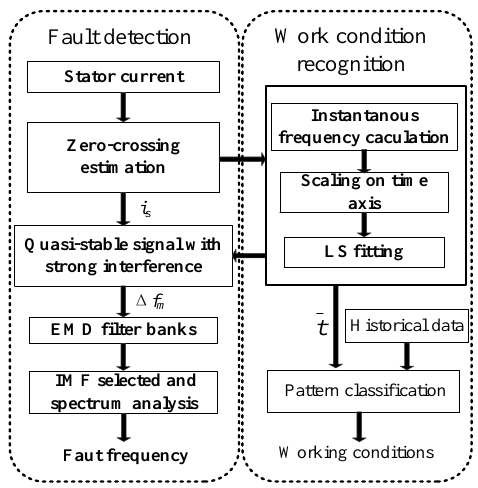
Figure 7. Flow chart of the proposed method.